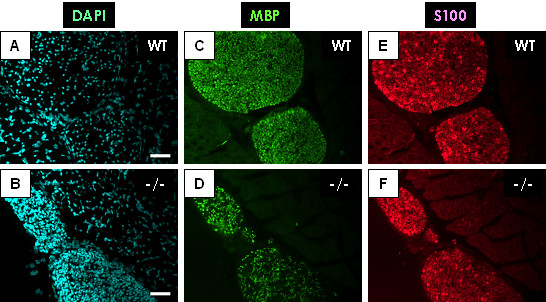
Marked delay in differentiation of the mutant Schwann cells. Transverse sections of the sciatic nerves of the indicated genotypes at postnatal day 13 were stained for MBP (C and D; green) or S100 (E and F; red), and were counterstained with DAPI (A, B; blue). In the mutant sciatic nerve, density of DAPI-signals were greatly increased (B) compared with those of the wild-type (A). Bar: (A, B) = 50 μm.